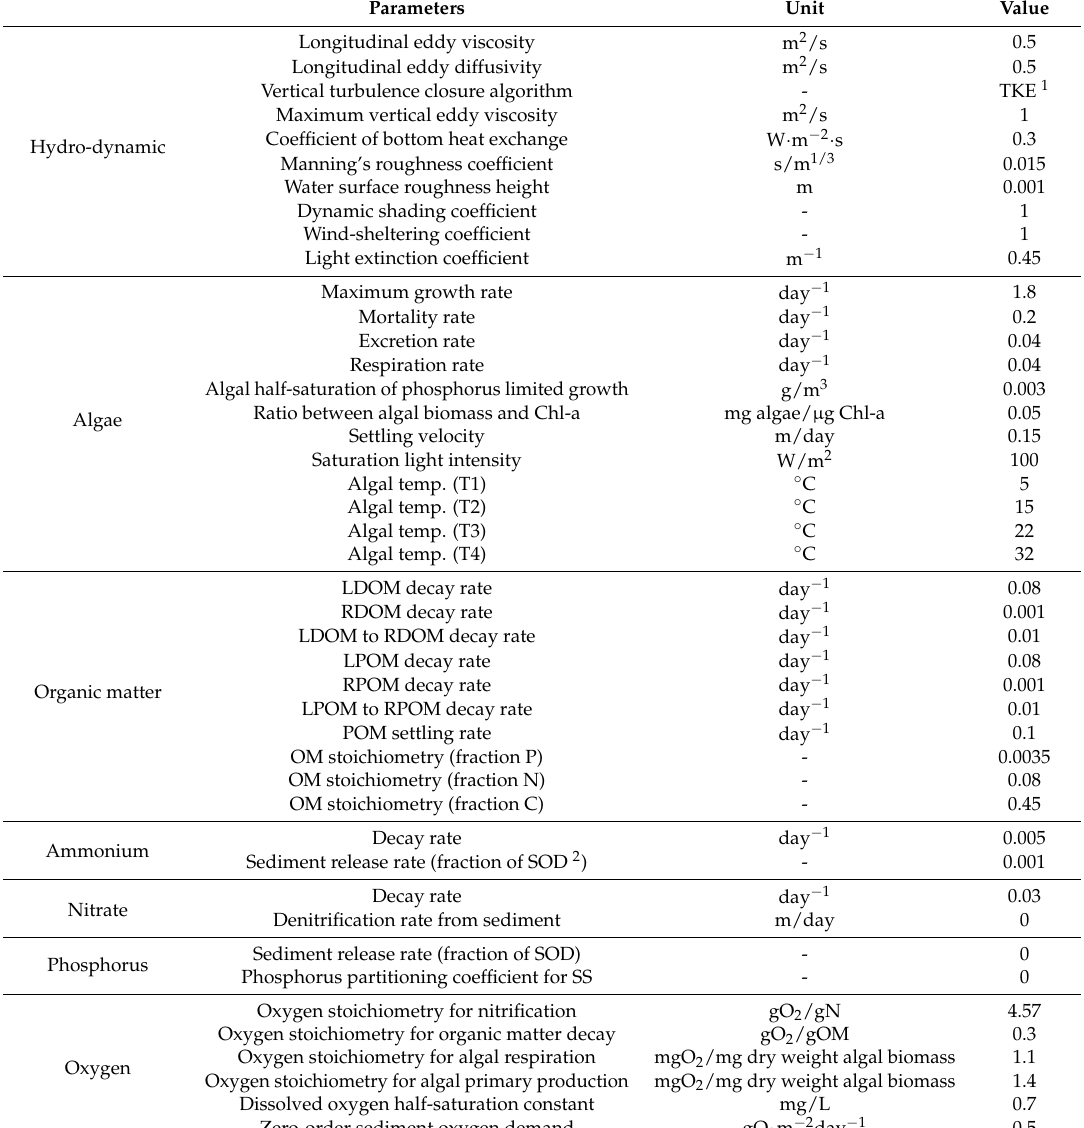
Table 1. Hydraulic and water quality parameters used for CE-QUAL-W2 model of